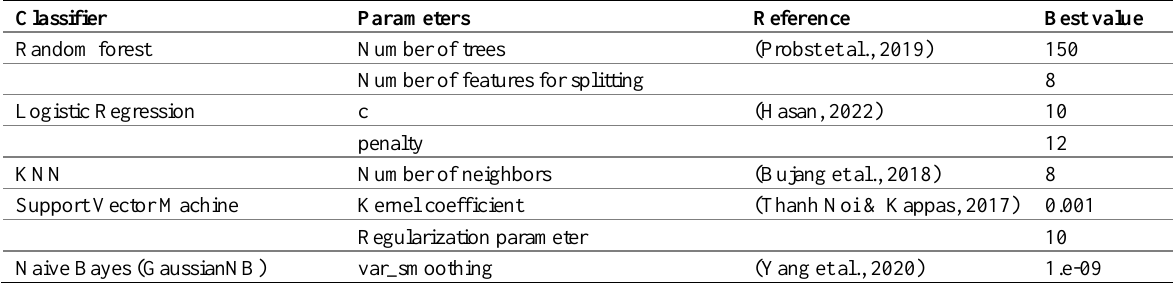
Table 5: Parameters for